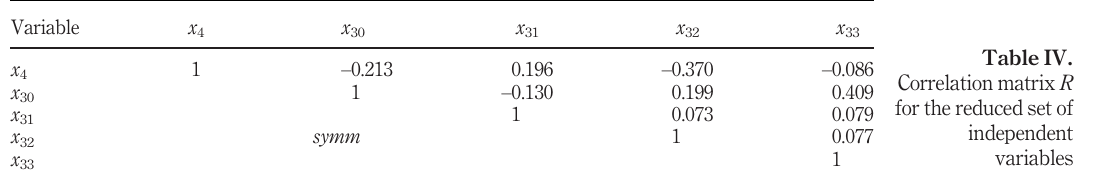
Table IV. Correlation matrix